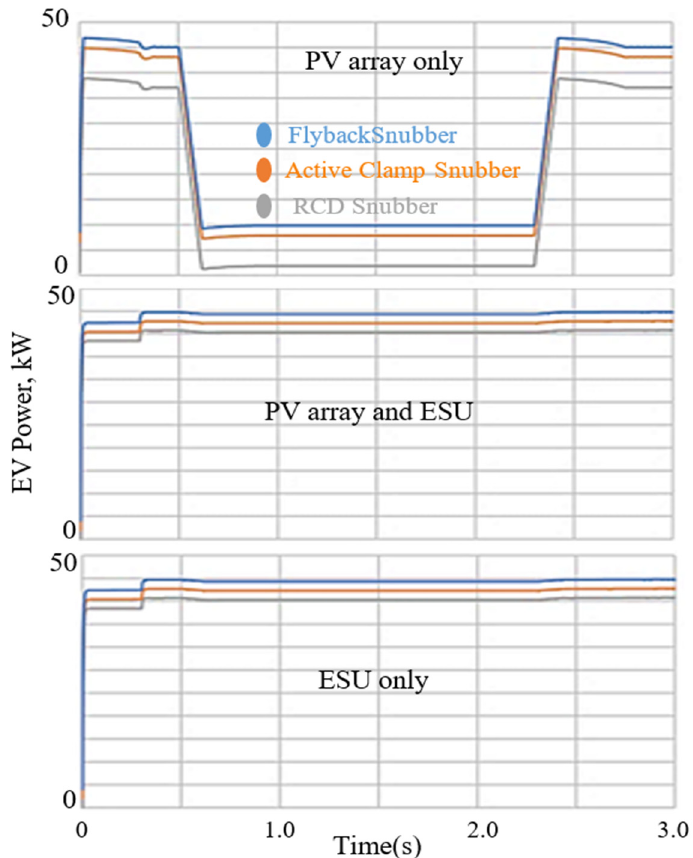
Figure 13. Output voltage of EVs load, using three different snubber circuits. Table 1. Comparative analysis of various snubber circuits.